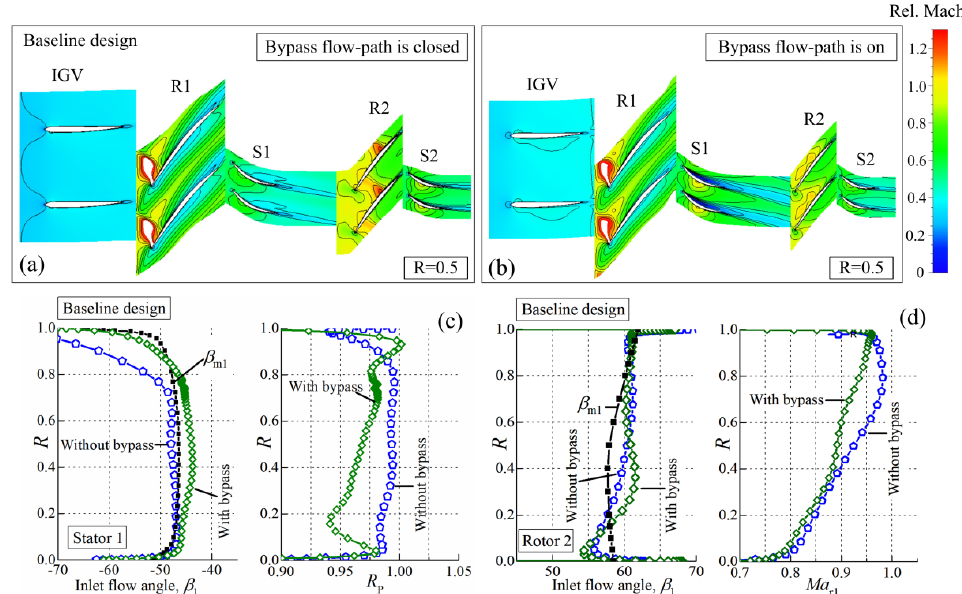
Figure 5. The relative Mach number contours of baseline design at mid-span ( R = 0.5) with bypass flow closed ( a ) and open ( b ); the flow parameter variation of Stator 1 ( c ) and Rotor 2 ( d ) at choke condition, (cid:1840) (cid:2887) = 0.8 .